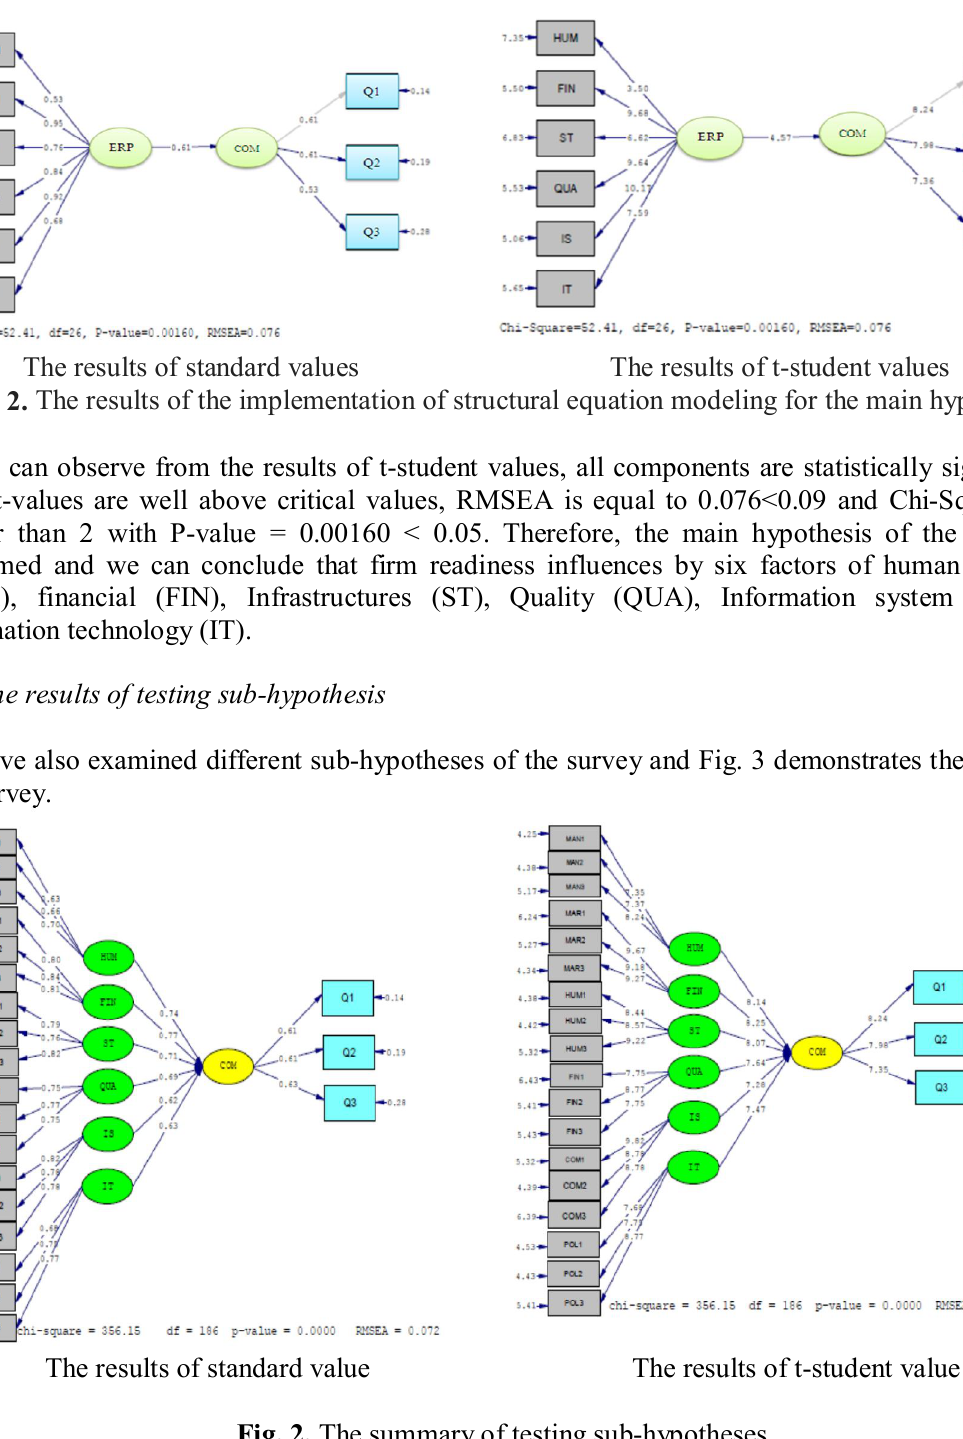
Fig. 2. The summary of testing